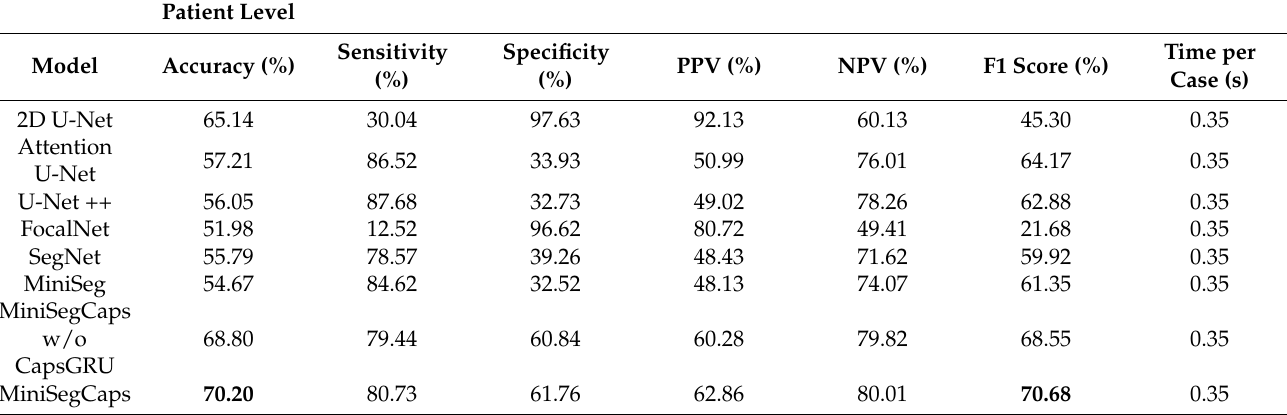
Table 6. Comparison of the patient-level performance between our method and baseline methods in prostate cancer classification on PI-RADS ≥ 3.